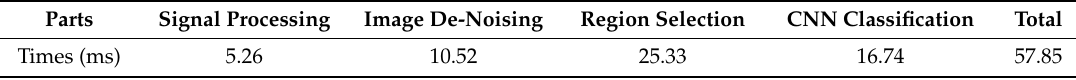
Table 4. Running time of processing parts per